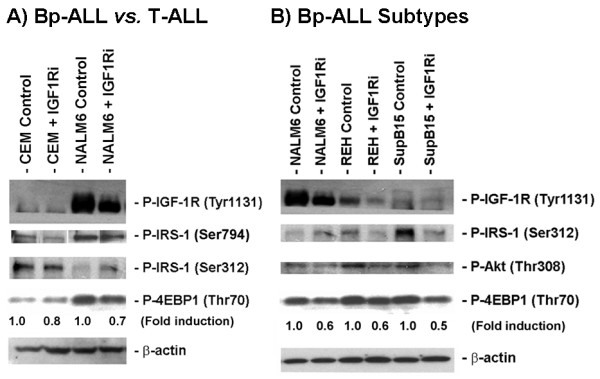
Expression level of IGF-1R and downstream regulated signaling factors in B-ALL vs. T-ALL cell lines. A) Western blot analysis of P-IGF-1R (Tyr1131), P-IRS-1 (Ser794 and Ser312), and P-4EBP1 (Thr70) expression in Bp-ALL (NALM6) and T-ALL cells (CCRF-CEM) treated with 0.1% DMSO (Control) or the IGF-1R inhibitor HNMPA(AM)3 (IGF1Ri, 10 μM) and incubated for 24 h. B) Basal expression level of P-IGF-1R (Tyr1131), P-IRS-1 (Ser312), P-Akt (Thr308), and P-4EBP1 (Thr70) in Bp-ALL NALM6 and subtypes characterized by non-random translocations (REH (t[12;21]), and SupB15 (t[9;22])). The levels of P-4EBP1 were normalized to β-actin (loading control) and expressed relative to control (shown as fold induction).